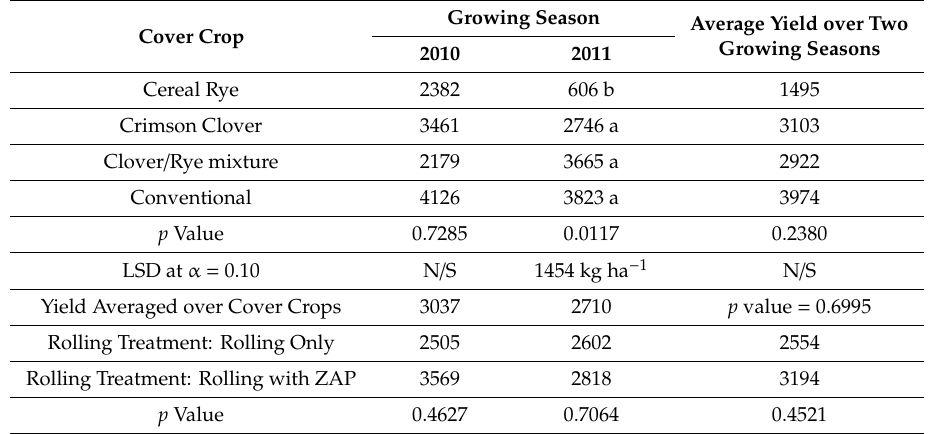
Table 7. Cantaloupe yield (kg ha − 1 ) with respect to cover crop treatments in 2010 and 2011 growing